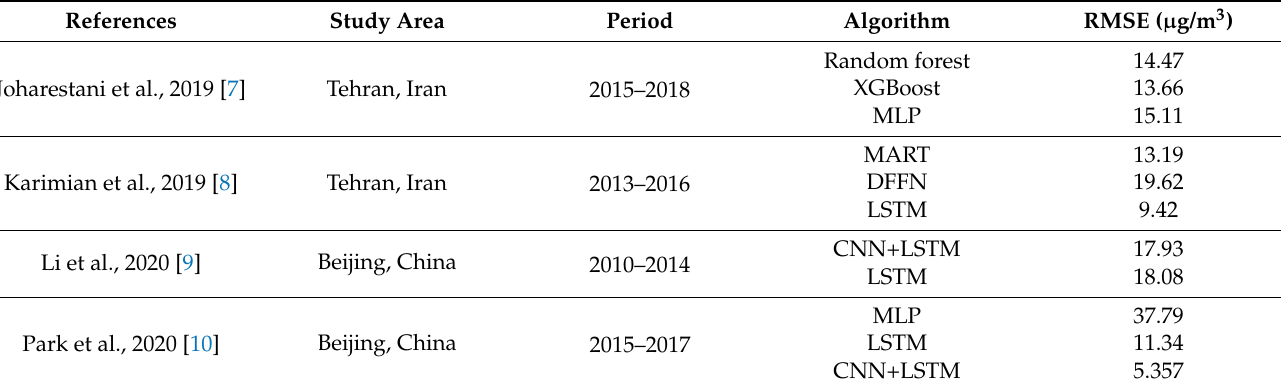
Table 1. Performance comparison between AI-based PM 2.5 prediction models